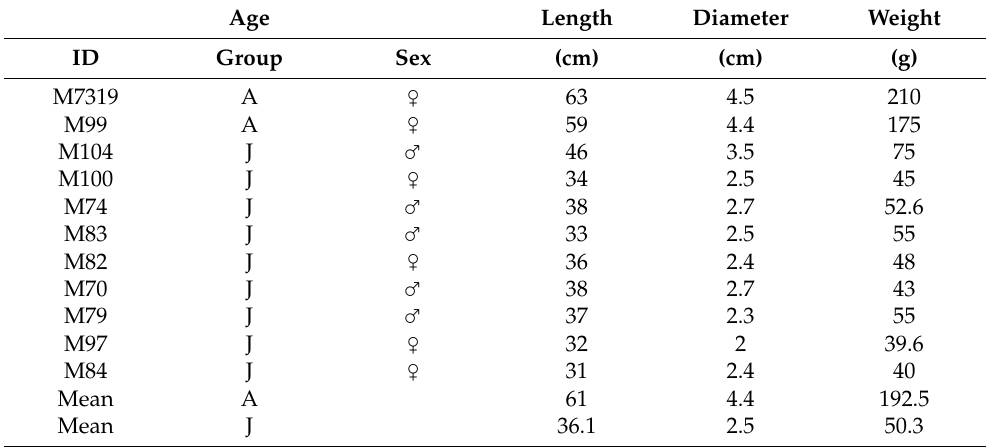
Table 2. Morphometric data of the Arctocephalus australis esophagus (11 specimens). A: adult; J: